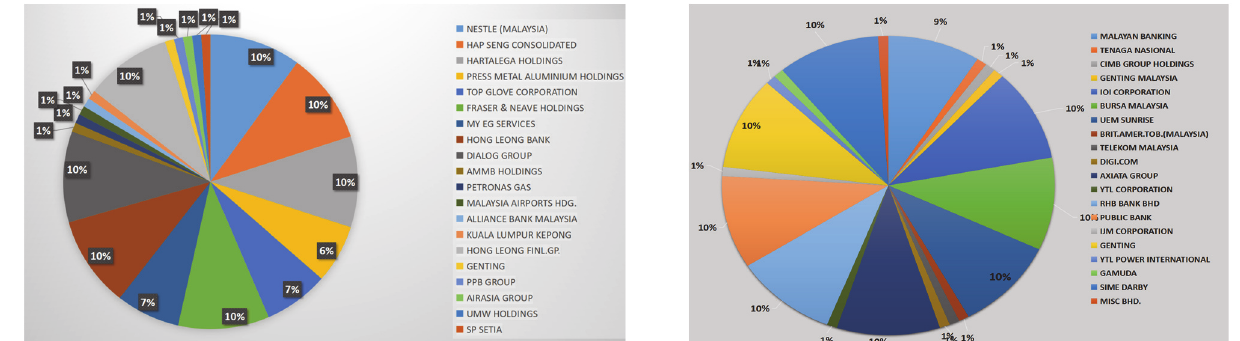
Fig. 1. Composition of Bottom Rating Sharpe Optimal Portfolio